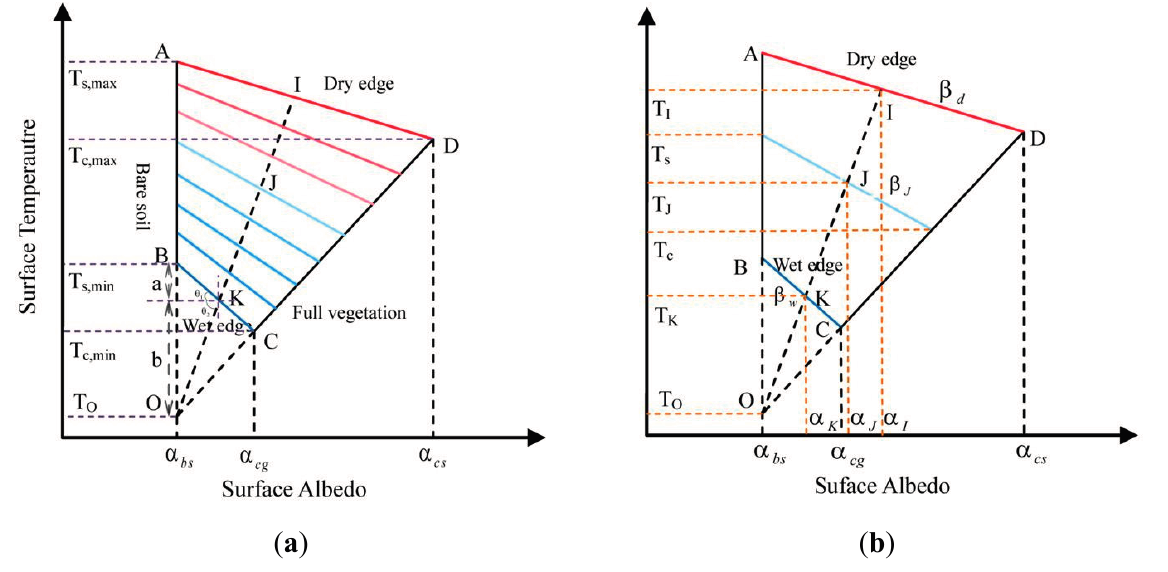
Figure 3. A sketch of the polygon T- α space involved in soil and vegetation component temperature separation. Points A and D pass through the dry line, and points B and C pass through the wet line according to SEB-1S model. The lines AB and CD represent the bare soil surface and fully vegetated surfaces, respectively. Slanting straight lines represent superimposed isopleths of soil moisture availability, which increase from dry edge to wet edge. ( a ) illustrates temperature and albedo end-members in the T- α and ( b ) illustrates the separation of soil and vegetation component temperatures from composite